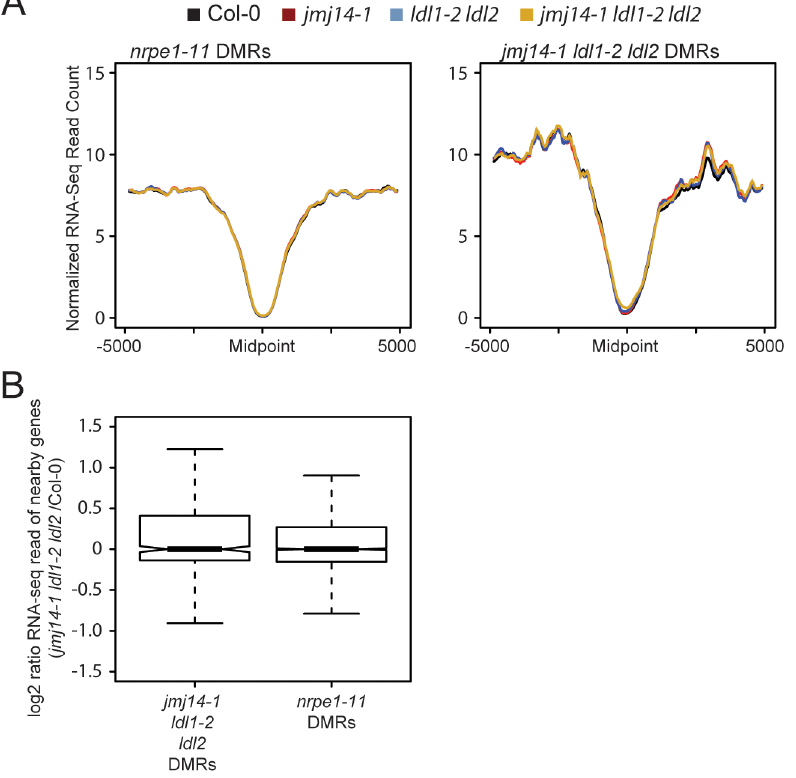
Figure 4. Changes in histone methylation at DMRs do not correlate with alterations in mRNA expression. (A) Metaplot of normalized RNA-seq read counts over nrpe1-11 and jmj14-1 ldl1-2 ldl2 DMRs. (B) log2 ratio of gene expression for genes with promoters overlapping with different DMRs.